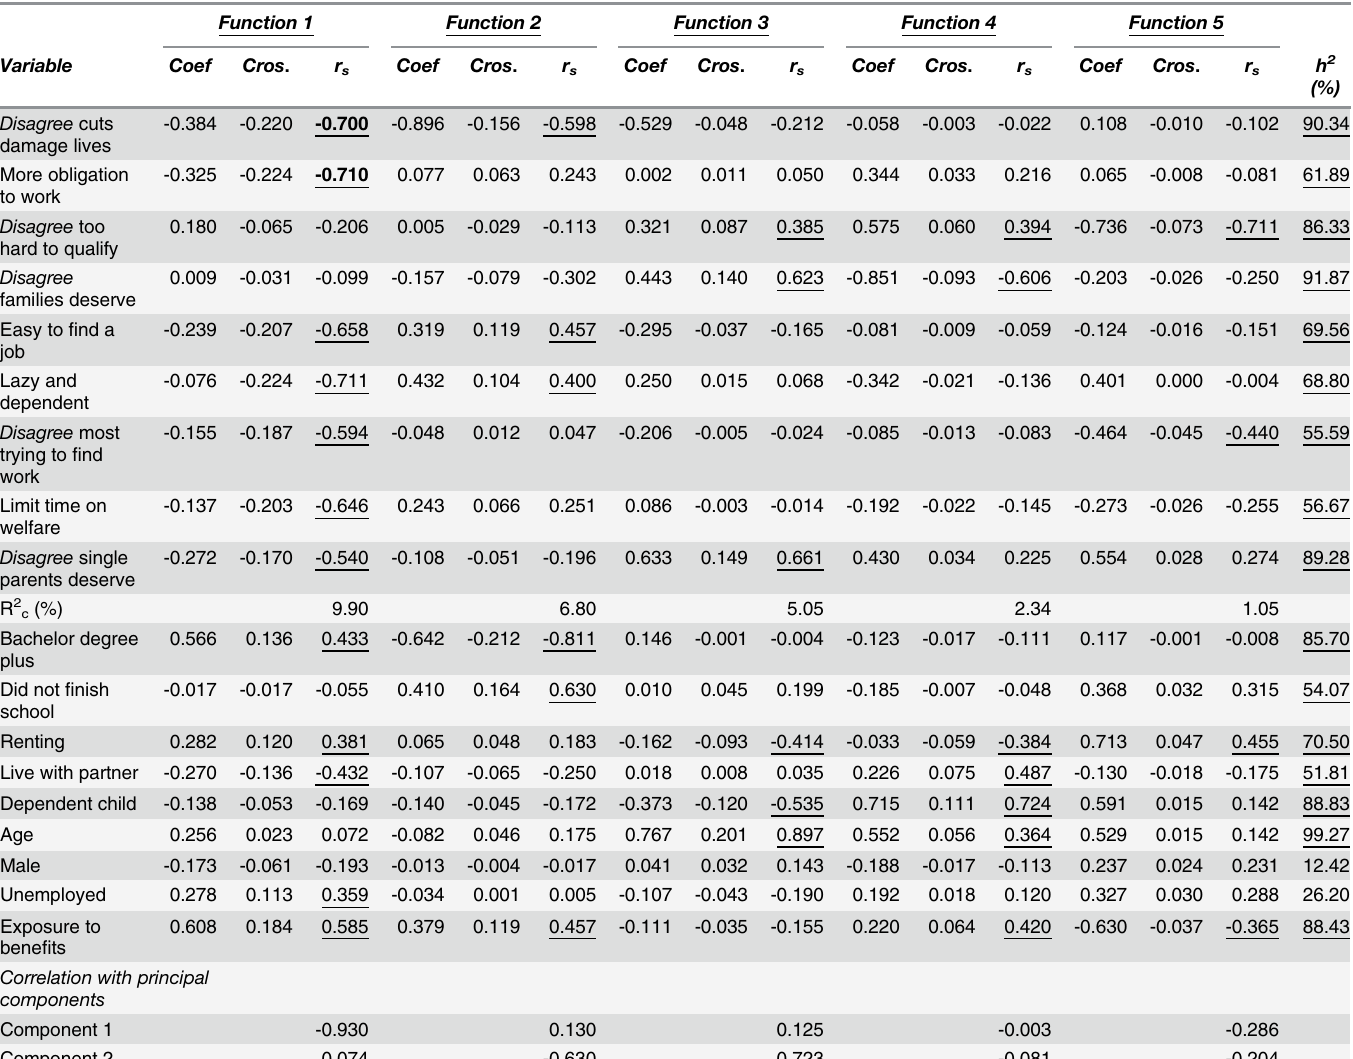
Table 5. Canonical solution for demographics predicting attitudes toward welfare for canonical functions 1 –